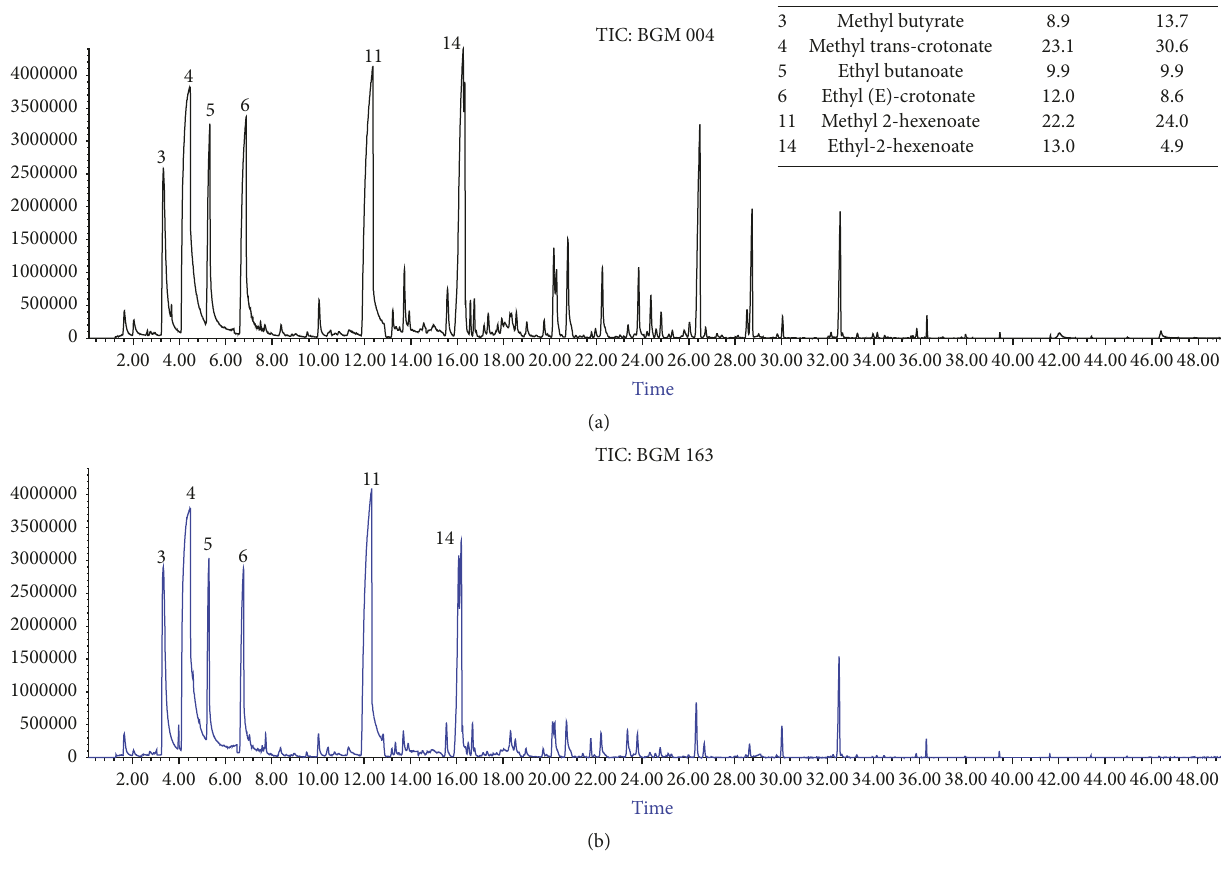
Figure 3: Typical total ions chromatograms and major volatile compounds of sweet passion fruits extracted by a 75 𝜇 m carboxen- polydimethylsiloxane (CAR/PDMS) fiber ((a) = genotype BGM004; (b) = genotype BGM163). Figure numbering corresponds to numbering in Table 1. Percentage refers to portion of total concentration of identified